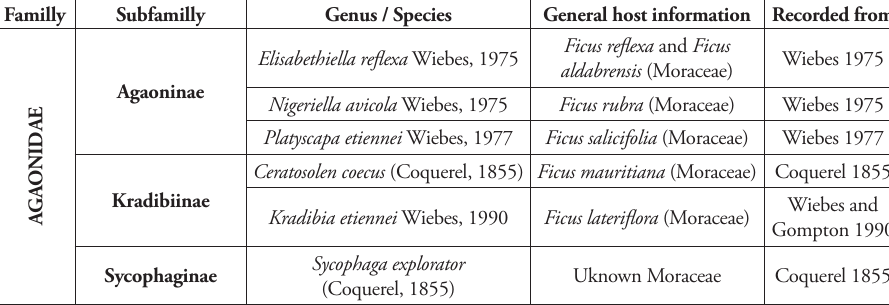
Table 2. List of the Chalcidoidea recorded from Reunion Island. Familly General host information Recorded